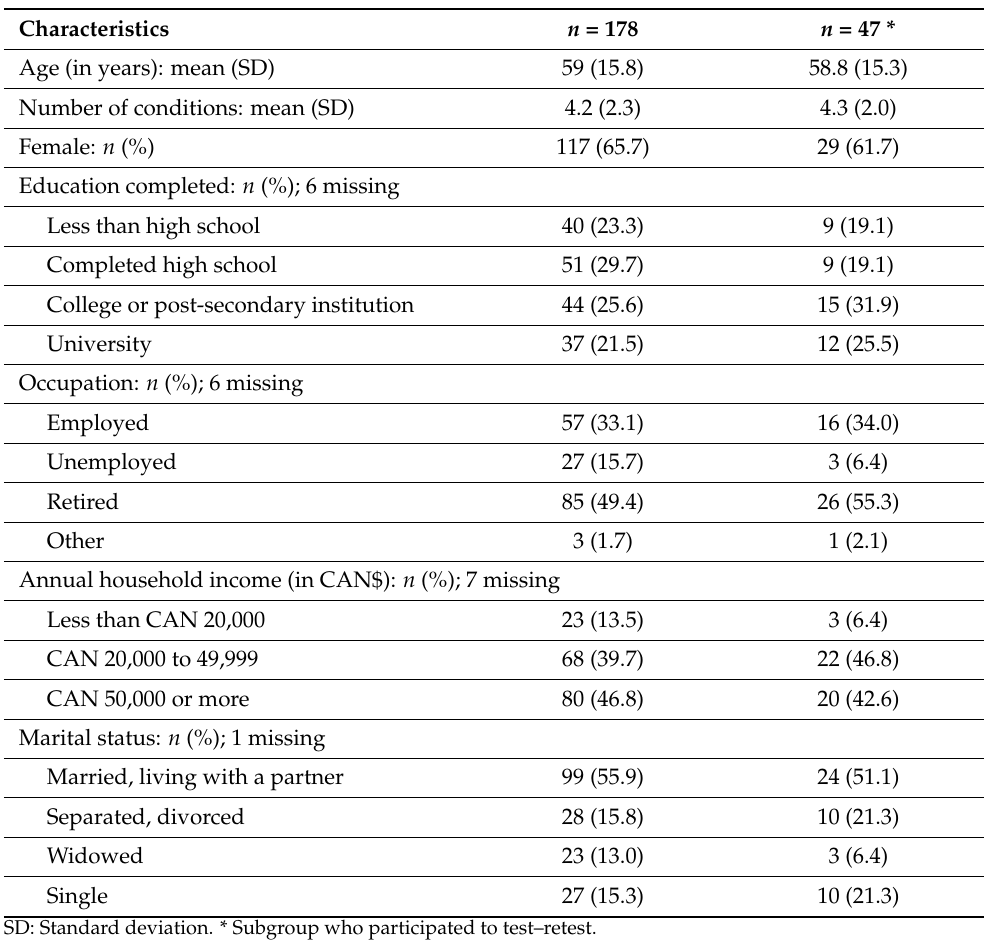
Table 3. Participant characteristics.